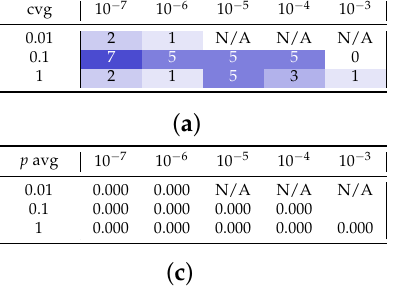
(b) Number of epochs before convergence, on average.